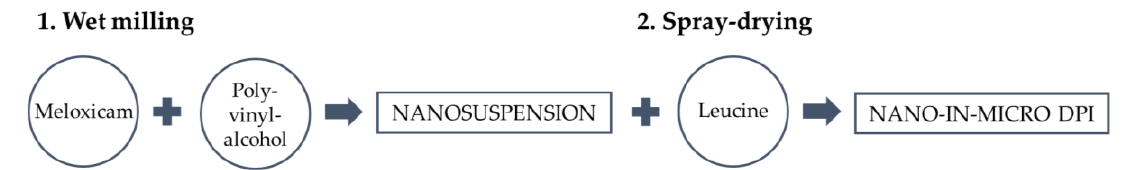
Figure 1. Two-step preparation method of the samples. DPI, dry powder